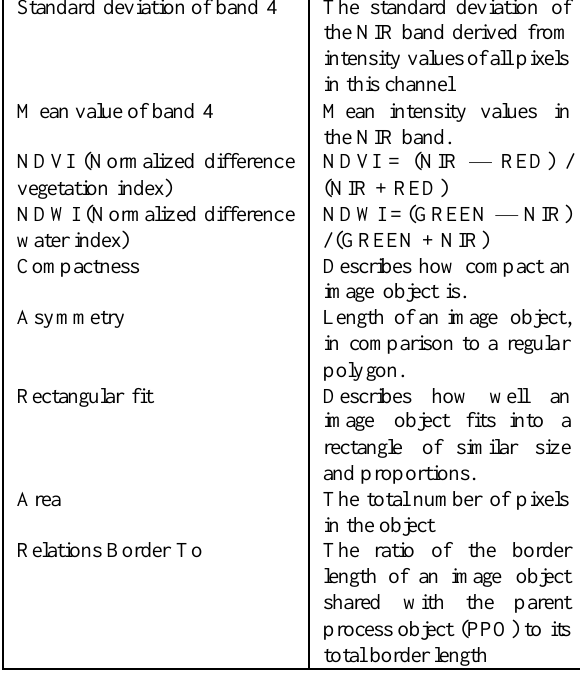
Table 3. Indices and functions lists (eCognition® Developer, Reference Book 2011, Antunes et al., 2003) Normalized Difference Water Index (NDWI) was used to classify water and non-water areas in study area. NDWI value was found 0.18 as a threshold to classify water bodies in SPOT 5 image while 0.12 as a threshold to classify water bodies in SPOT 6 image. Therefore, the segments having NDWI value that were above the limit values were assigned to water class (code 50000). Open Street maps road data which included roads and railway roads obtained in vector format were integrated into the segmentation process as a thematic layer to clearly identify road and rail network (code 12200) and its sub-classes (code 12230).